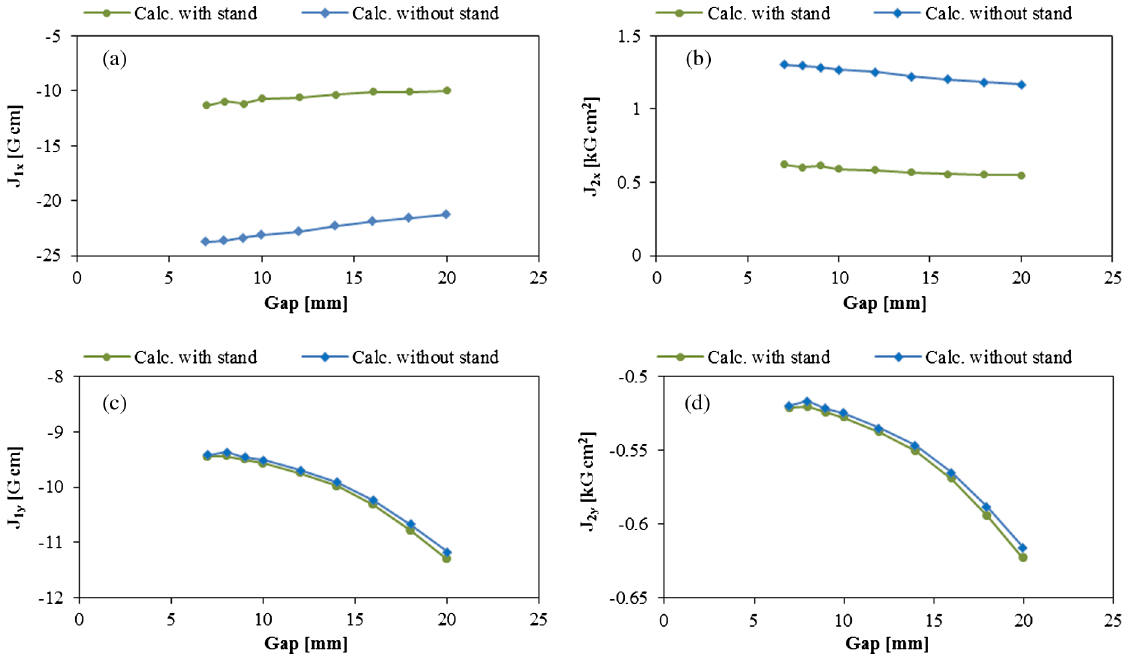
FIG. 15. Field integrals for horizontal undulator (UNA33 with 33-mm period magnetic structure): (a) first horizontal field integral; (b) second horizontal field integral; (c) first vertical field integral; (d) second vertical field integral. External field is B x ¼ 0 . 15 , B ¼ − 0 . 4 y